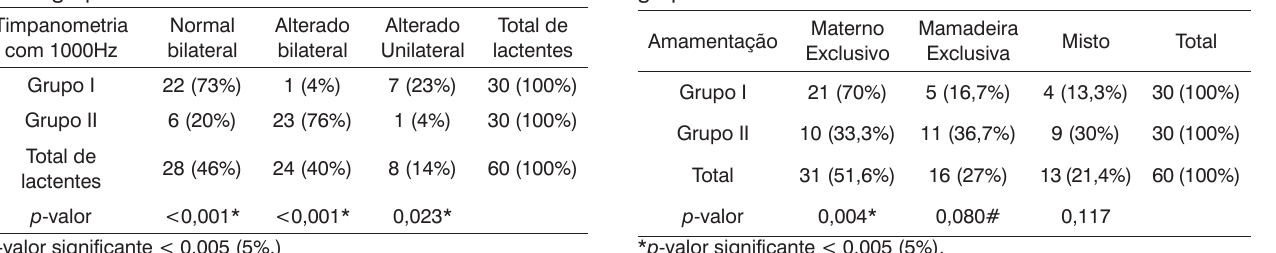
Tabela 4. Resultados da timpanometria com tom teste de 1000 Hz nos grupos estudados.